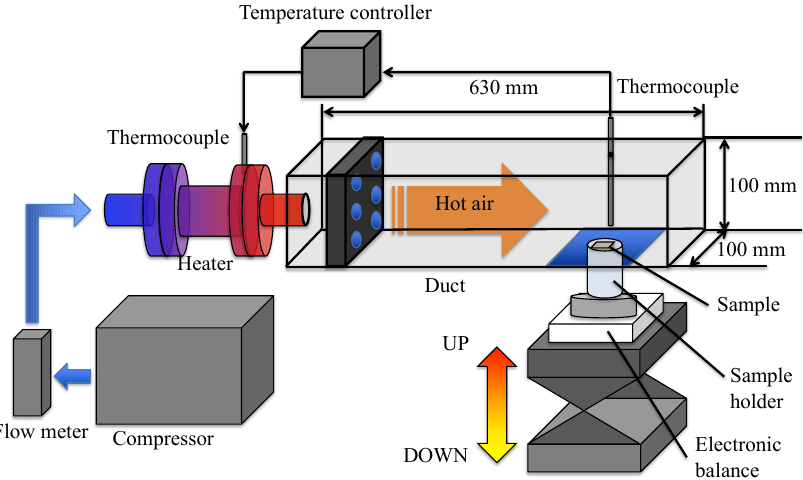
Figure 3. Outline of hot-air drying experimental setup (one side drying of sample).